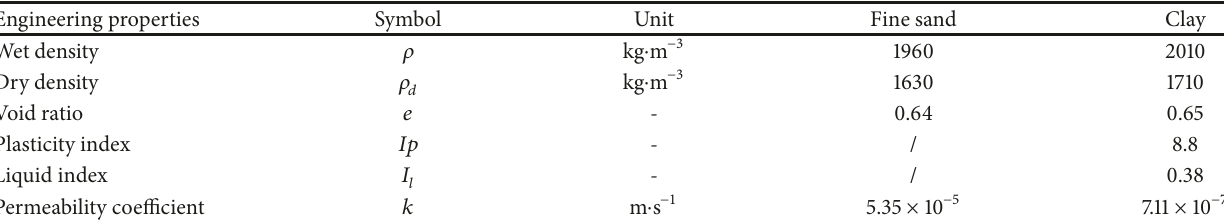
Table 1: Engineering properties of the foundation